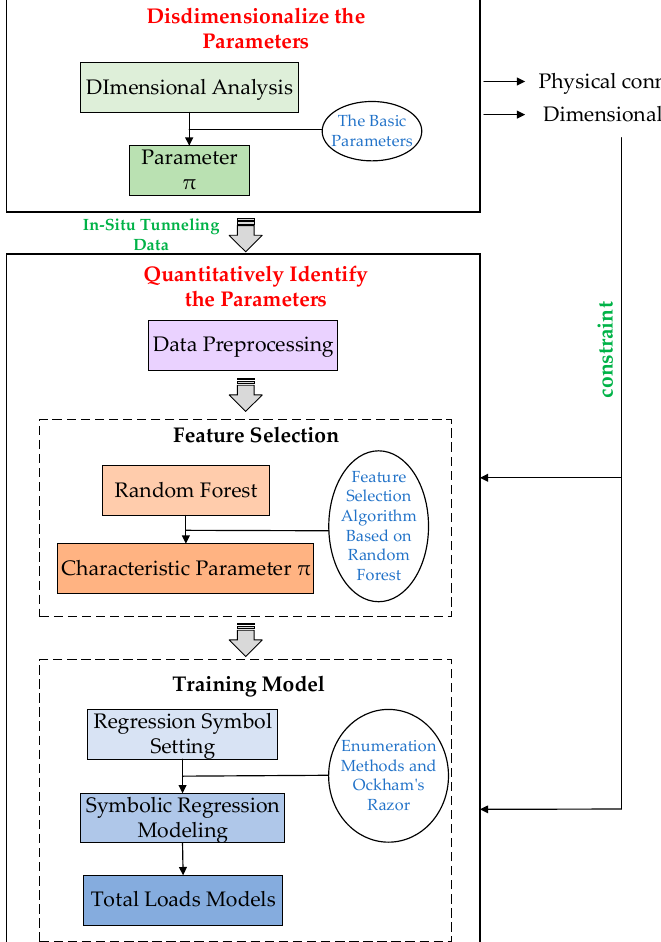
Figure 1. Modeling